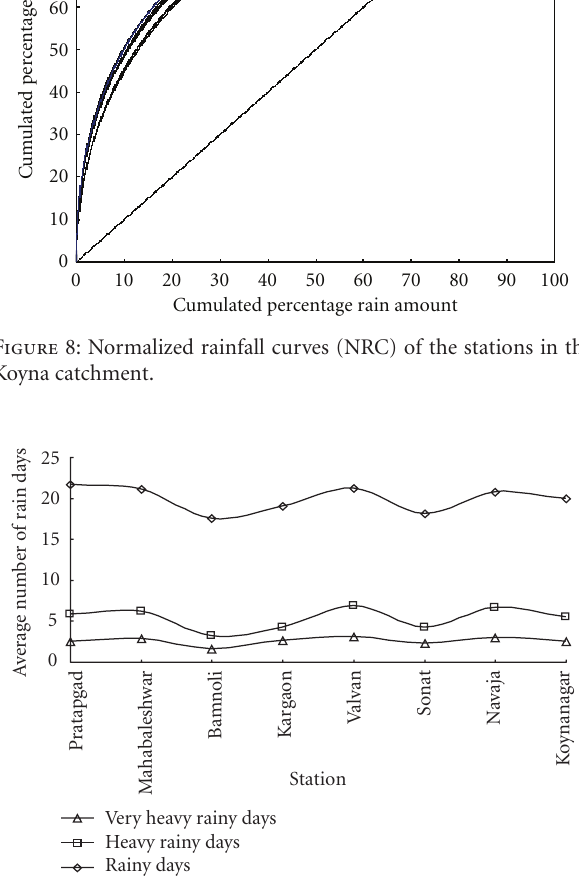
Figure 9: Stationwise distribution of rainy days over the Koyna catchment.